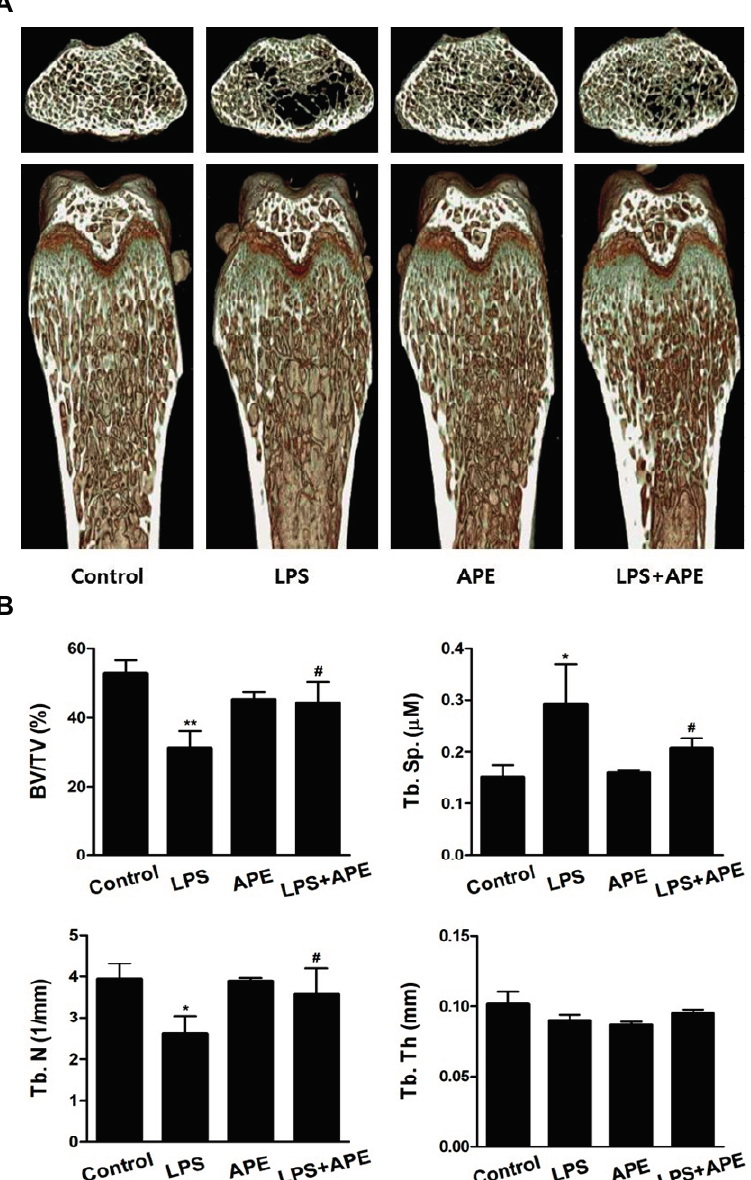
Figure 1. Aconitum pseudo-laeve var. erectum (APE) regulates lipopolysaccharide (LPS)-induced bone erosion in a mouse model. ( A ) Mice were sacrificed 8 days after the first LPS injection and radiographs of the longitudinal and transverse section of the proximal femurs were obtained using a micro-computed tomography (micro-CT) apparatus; ( B ) The bone volume per tissue volume (BV/TV), trabecular separation (Tb.Sp), Tb.Th, and trabecular number (Tb.N) of the femurs were determined using the micro-CT data as analyzed with INFINITT-Xelis